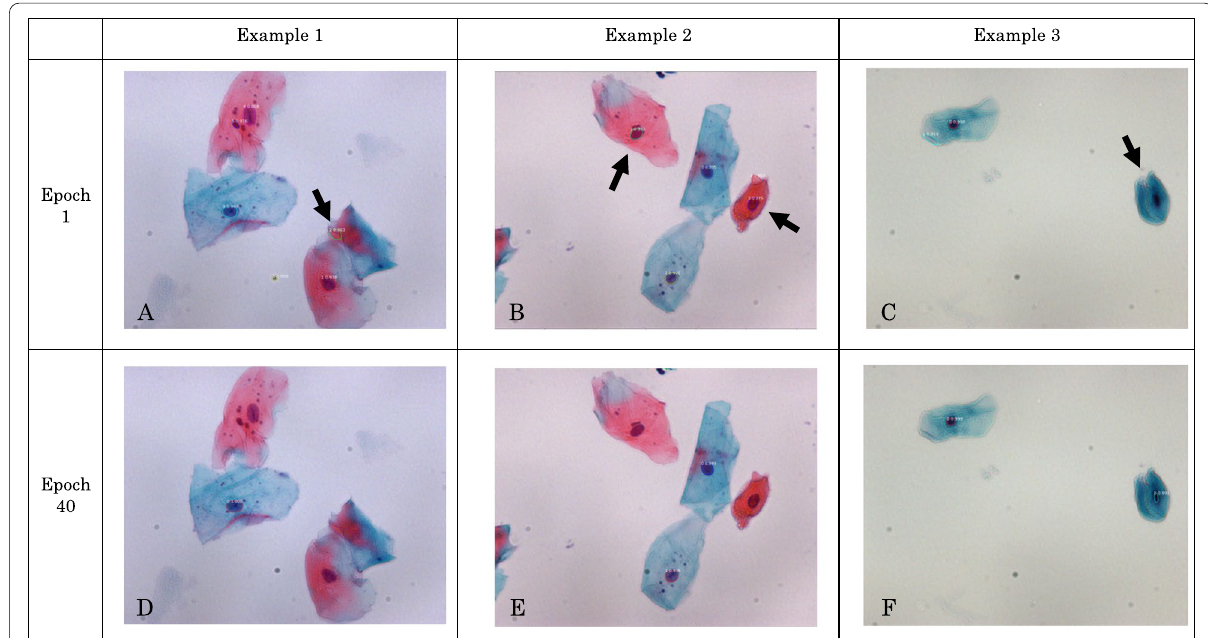
Fig. 4 Detection of cell nuclei using the region-based convolutional neural network method. Epoch 1 indicates the start of learning, while epoch 40 indicates the end of learning 40 times. Epoch 1 can identify the parts other than the cell nuclei ( A ), red cell nuclei ( B ), and blue absent cell nuclei ( C ). Learning allowed the discrimination of the blue-tinted nuclei alone ( D , E , F ), and the discrimination performance was improved